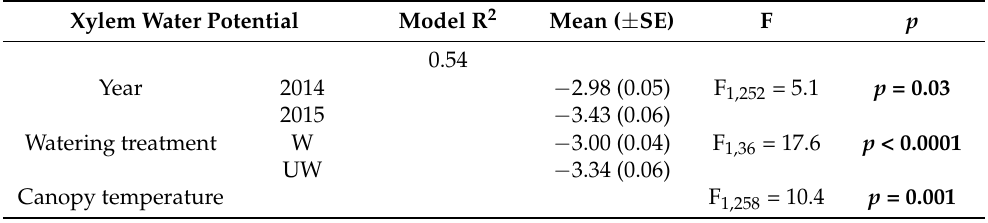
Table 1. Results of multiple linear regression with monthly mean tree canopy temperature, watering treatment, and year predicting mean A. rubrum xylem water potential in June through August of 2014 and 2015. Bolded p -values are statistically significant ( p <